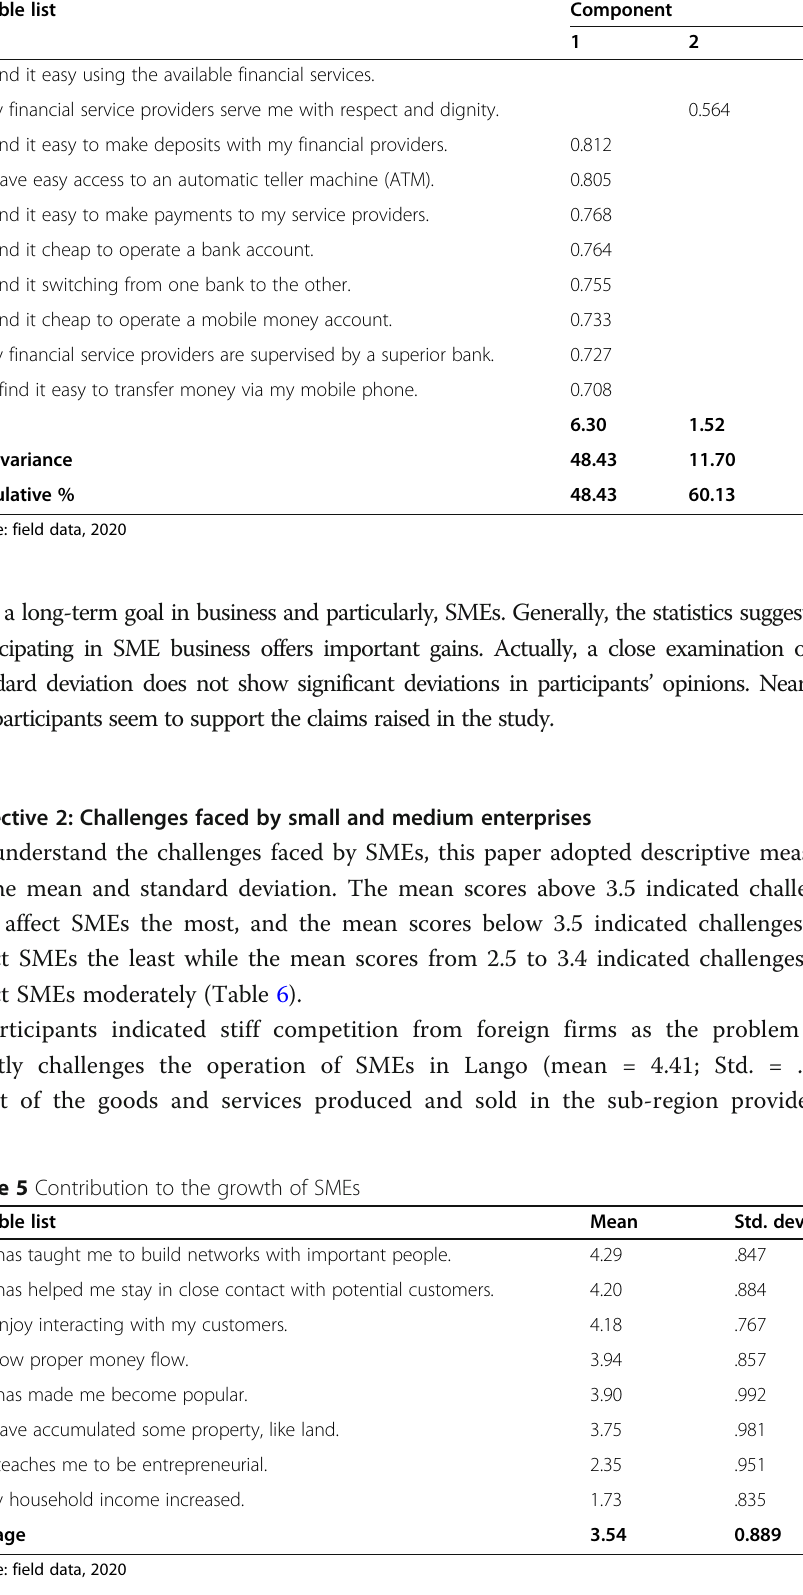
Table 4 Factor analysis on the financial inclusion Variable list